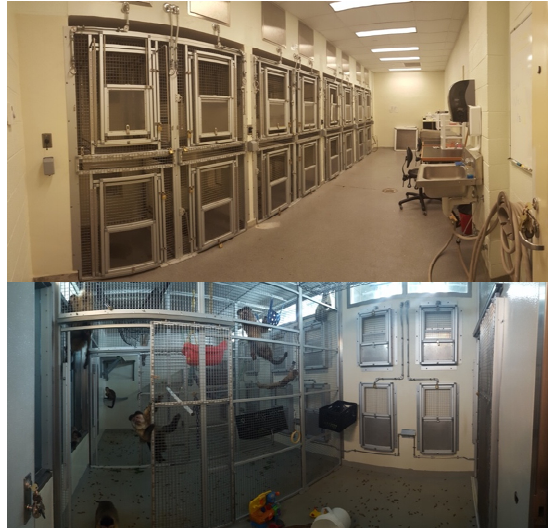
Figure 2. Photographs of the facility from the testing room ( top ) and the entry area ( bottom ). On the white wall on the right side of the bottom photograph, four of the 16 sliding doors to the testing cubicles are visible. These doors can be secured open or closed, so caretakers and trainers have the option to close either the mesh screen door, the solid metal panel door, or both.